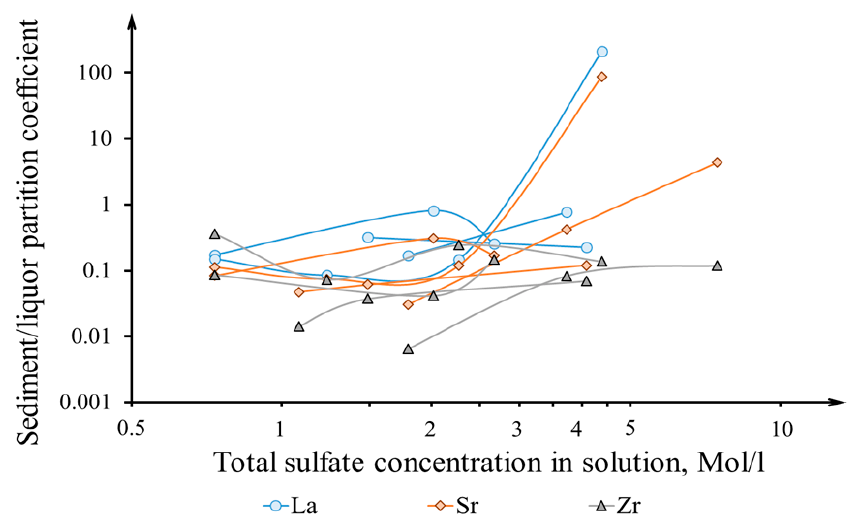
Figure 7. Distribution of Sr, Zr, and La between the sediment and liquor. The results of tests of three solution samples for each element show that the distribution of these micro-components is more random, and the figures obtained in different experiments may not coincide with each other. It can be seen that, with an